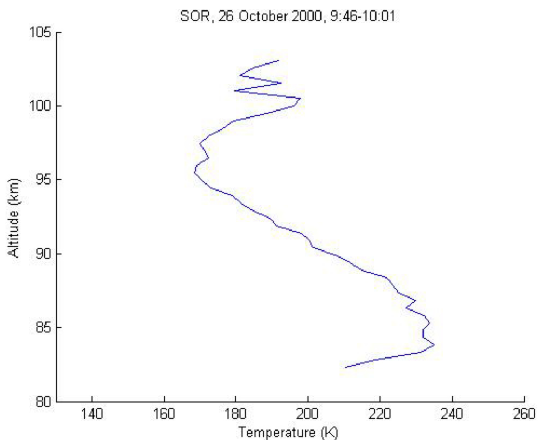
Fig. 9. Temperature profile averaged for about 15min during the overturning event on 26 October